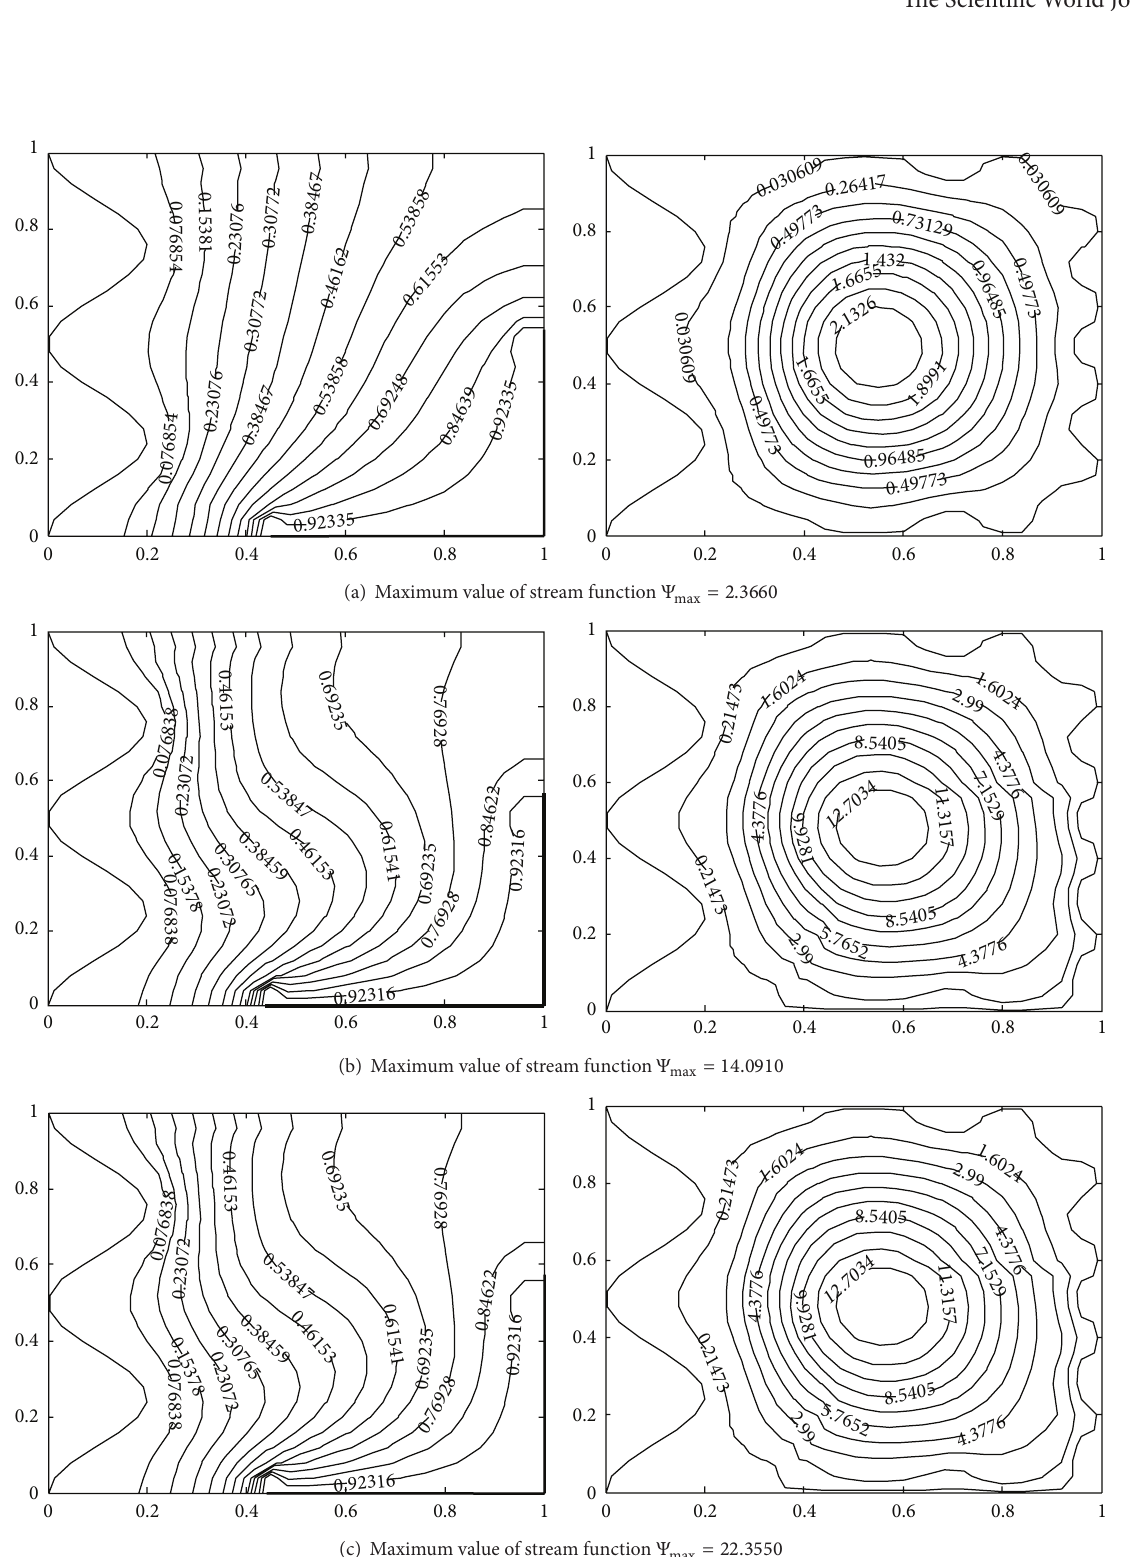
Figure 6: Temperature contours (on the left) and streamlines (on the right) with different Prandtl number at Ra = 10 5 , 𝐴 = 0.2 , 𝑛 = 2 , ℎ𝑥 = 0.55 , ℎ𝑦 = 0.55 , (a) Pr = 0.07 , (b) Pr = 0.7 , and (c) Pr = 7.0